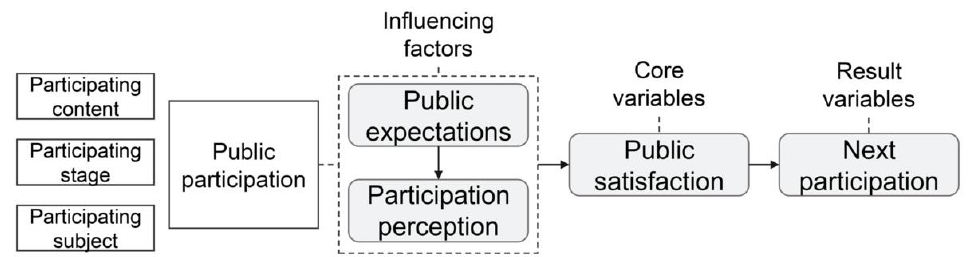
Figure 2. Analysis of the satisfaction of public participation framework. (Source: the authors).